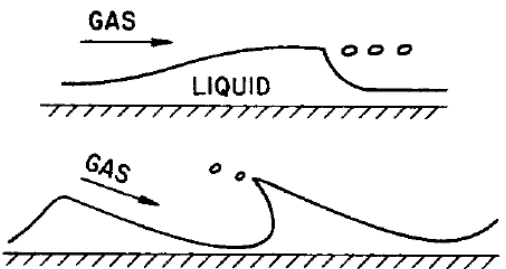
Figure 2. Entrainment hypotheses on shearing-off the disturbance wave crest ( top ) and disturbance wave undercutting ( bottom ) [29].